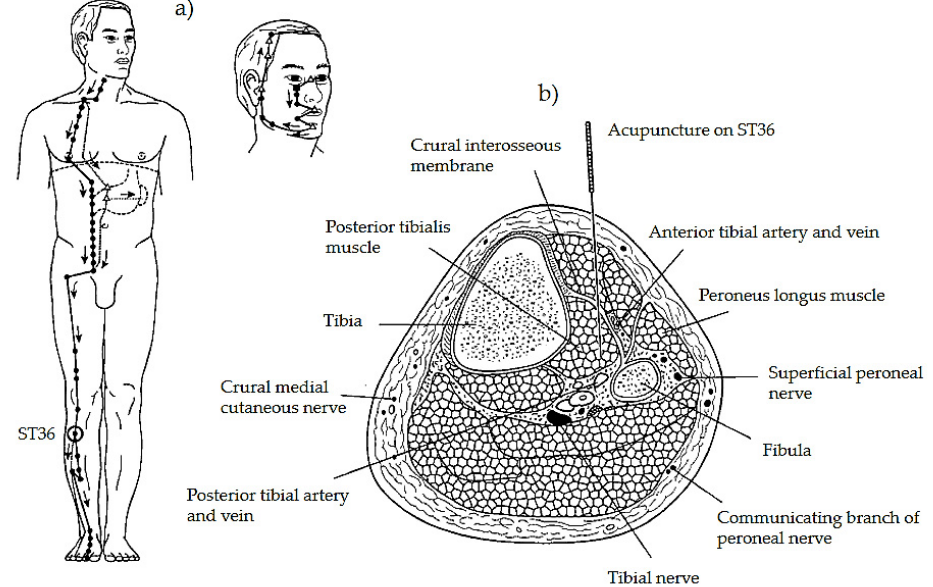
Figure 7. Representation of the stomach meridian and the location of ST36 ( a ). Cross-section of the lower limb at ST36, showing the anatomical structures and a needle puncturing the acupoint ( b ). Reprinted with permission from ref. [64]. Copyright 2002 Elsevier (Amsterdam, The Netherlands) and Copyright Clearance Center (Danvers, MA, USA).